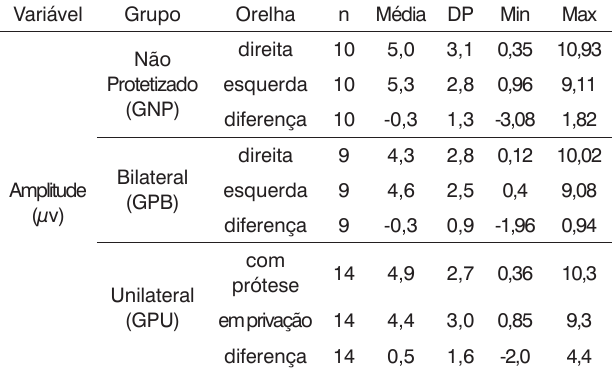
Tabela 2. Média da relação S/R (fones) e desvio padrão (DP) no teste LSP para cada orelha e para as diferenças (em dB), para os três grupos. Valores Mínimos (Min) e Máximos (Max) são disponibilizados.